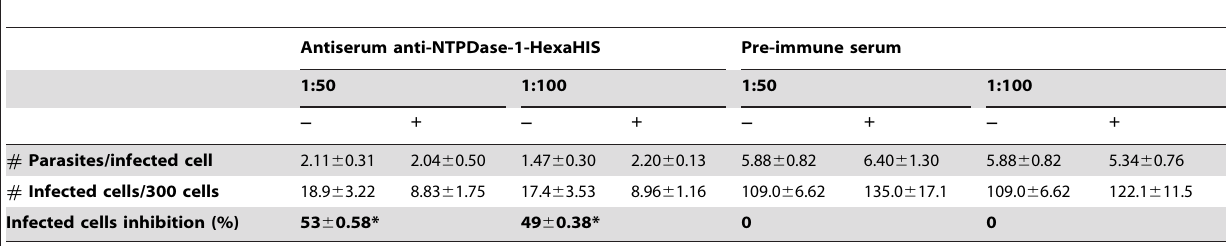
Table 2. Effect of antiserum anti-NTPDase-1-HexaHIS or pre-immune serum on in vitro infectivity of trypomastigotes.